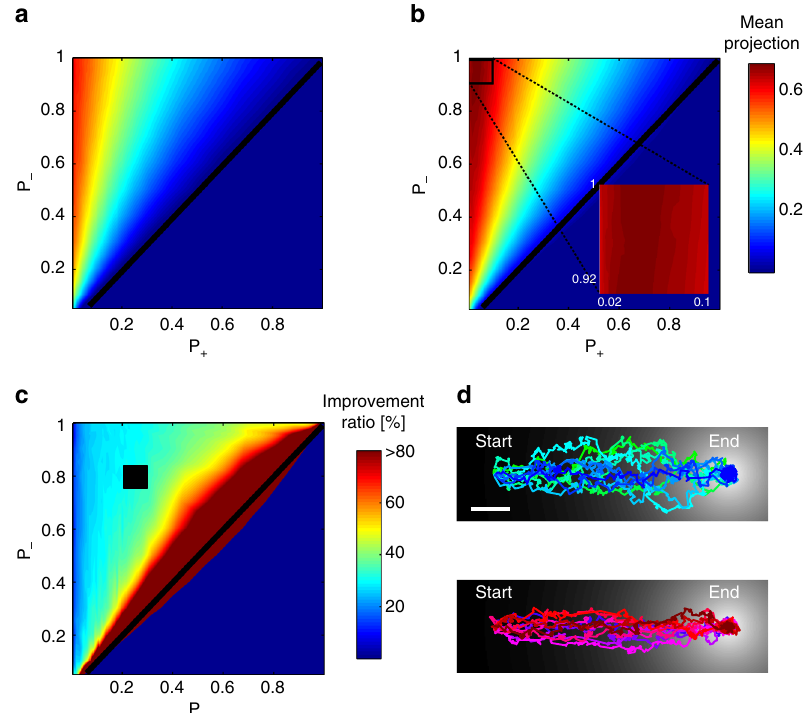
Fig. 5 Implementing adaptation to the fi rst derivative promotes ef fi cient navigation a , b Chemotaxis performance when simulating: a the classical biased- random walk strategy, and b the strategy which incorporates adaptation to the fi rst derivative. Axes denote turning probabilities when experiencing a positive gradient ( x -axis, P + ) and a negative gradient ( y -axis, P - ). Color marks chemotaxis score (performance), measured as the mean projection of the velocity vector on the optimal (direct) trajectory line (see methods for details). Black diagonal marks the P + = P - line. Zoomed-in box of the top-left square shows the maximal chemotaxis score. Interestingly, the maximal score is achieved for P + > 0, meaning that better performance is achieved when allowed to occasionally reorient, even if sensing continuous increasing gradients. c Fold-improvement in the performance between the strategy that incorporates adaptation to the fi rst derivative ( b ), and the classical biased-random walk strategy ( a ). The fold-improvement is de fi ned as 100 ⋅ ( fi rst derivative adaptation score — classical biased-random walk score)/(classical biased-random walk score). Throughout the entire parameters ’ space, the strategy of adapting